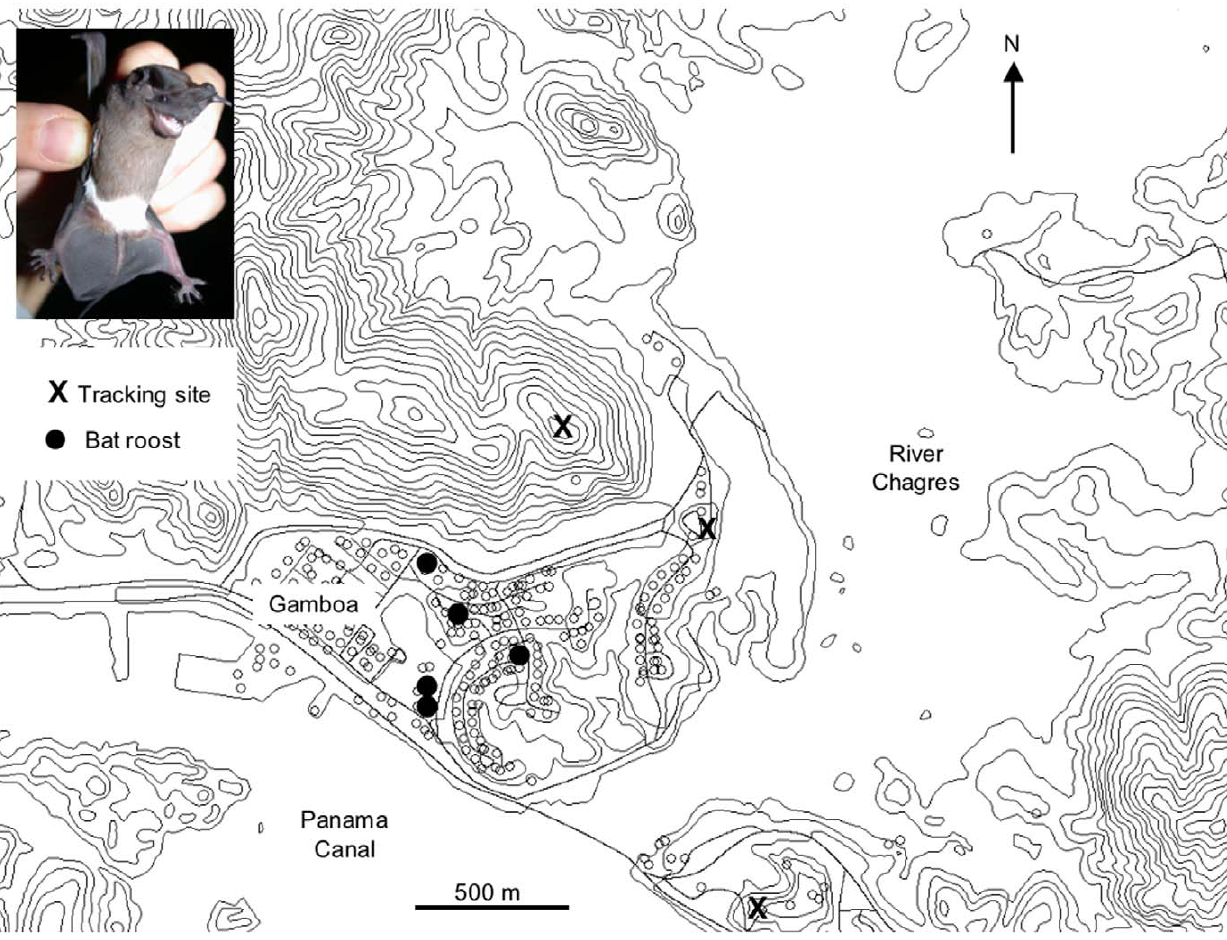
Figure 1. Map of the study area showing the Chagres river entering the Panama Canal and the village of Gamboa, the location of roosts where radio-tracked bats were caught as well as our main tracking points.